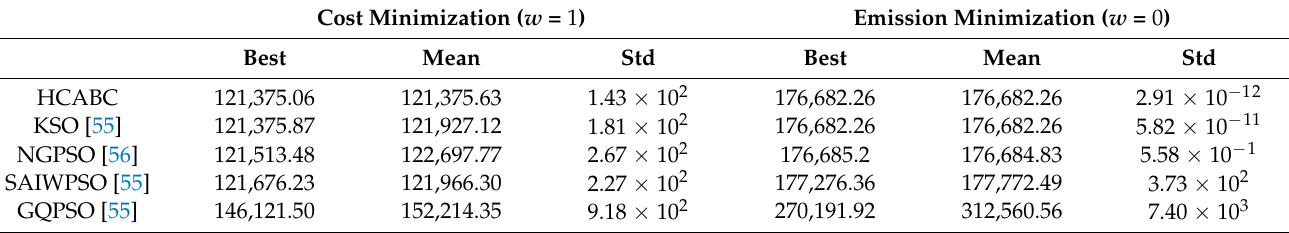
Table 5. Statistical results for case